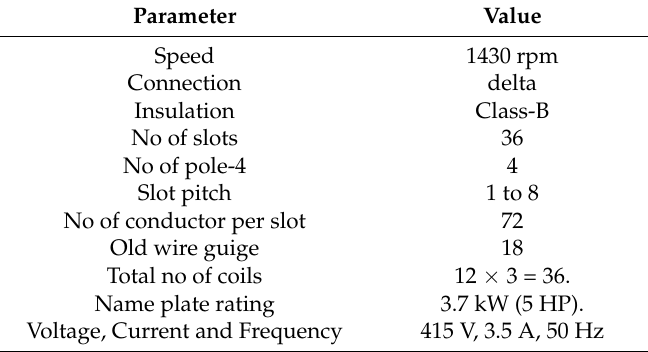
Table 3. Parameters of the old induction machine (IM).